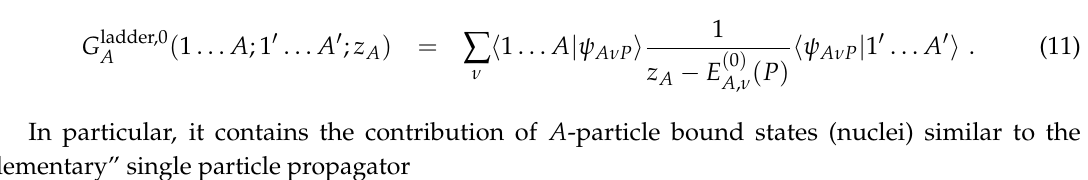
for A = 2. Iteration gives the infinite sum of ladder A